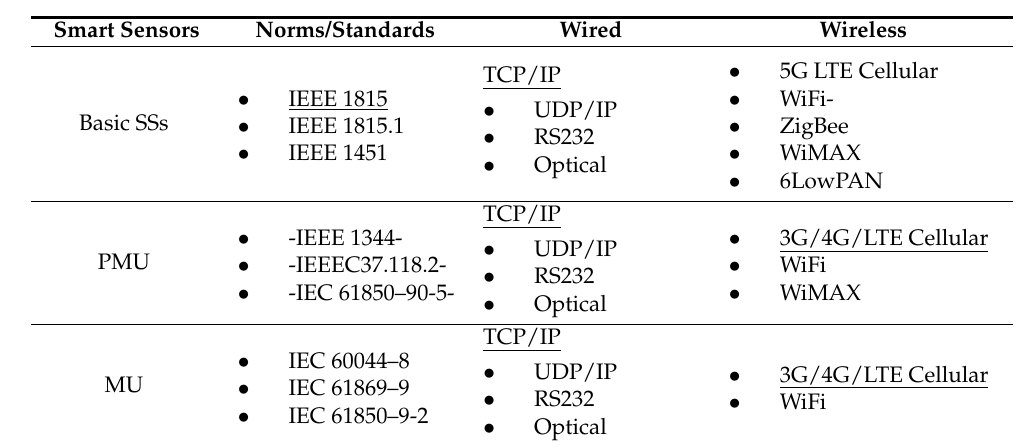
Figure 4. Smart Sensor model for SGs. Table 2. SSs Standard